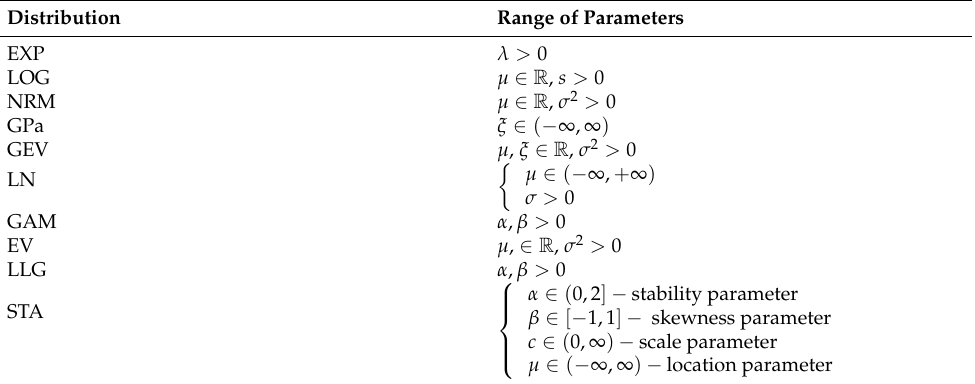
Table 3. Range of the distribution